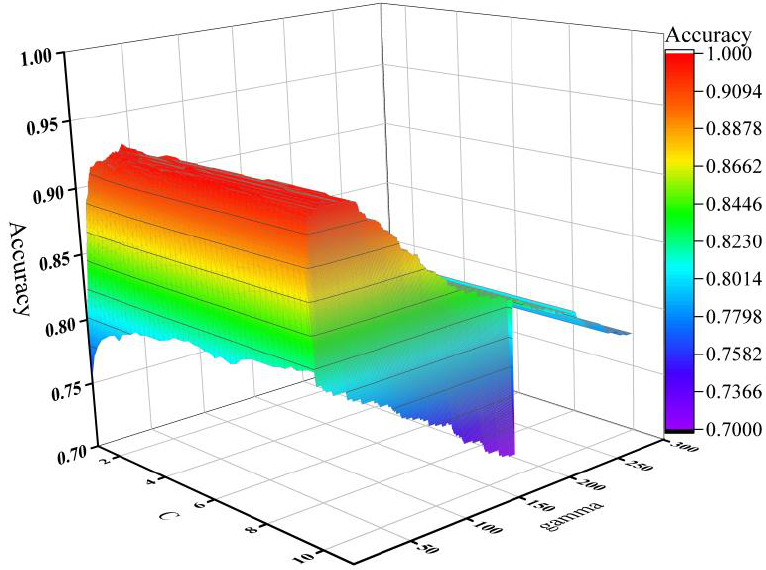
Figure 12. The accuracy of GA_SVM with different C and g values.